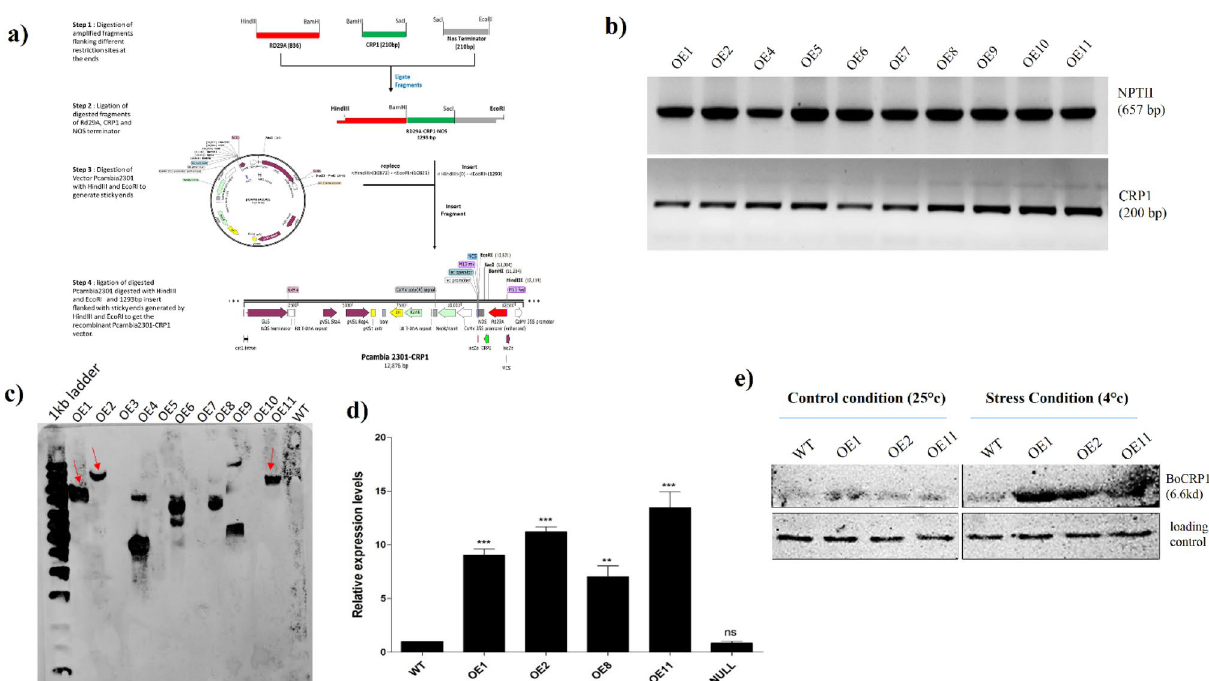
Figure 3. Cloning and molecular analysis of transgenic plants. ( a ) Schematic representation cloning strategy of BoCRP1 gene (Green) under stress inducible promoter Rd29A (Red) in plant binary vector Pcambia2301 ( b ) screening of kanamycin positive lines by PCR, using NPTII and CRP1 specific primers. ( c ) Southern blot analysis of PCR positive transgenic lines for single copy insertion lines. The dioxyginin labelled NPTII probe were used to check the insertion and copy number of T-DNA regions within the plant genome. Only four transgenic lines were found to contain single copy T-DNA region. ( d ) Expression pattern of BoCRP1 transcript in four different transgenic lines after cold stress. qRT-PCR analysis depicts that out of four putative transgenic lines , expression of BoCRP1 is higher in OE1, OE2 and OE11. ( e ) Western blot indicating the expression of BoCRP1 protein in different overexpression lines under both normal and cold conditions using GAPDH as loading control. Asterisks indicate significant differences between wild-type (WT) and transgenic lines). * P < 0.05; ** P < 0.01; *** P < 0.001 Tukey’s Multiple Comparison